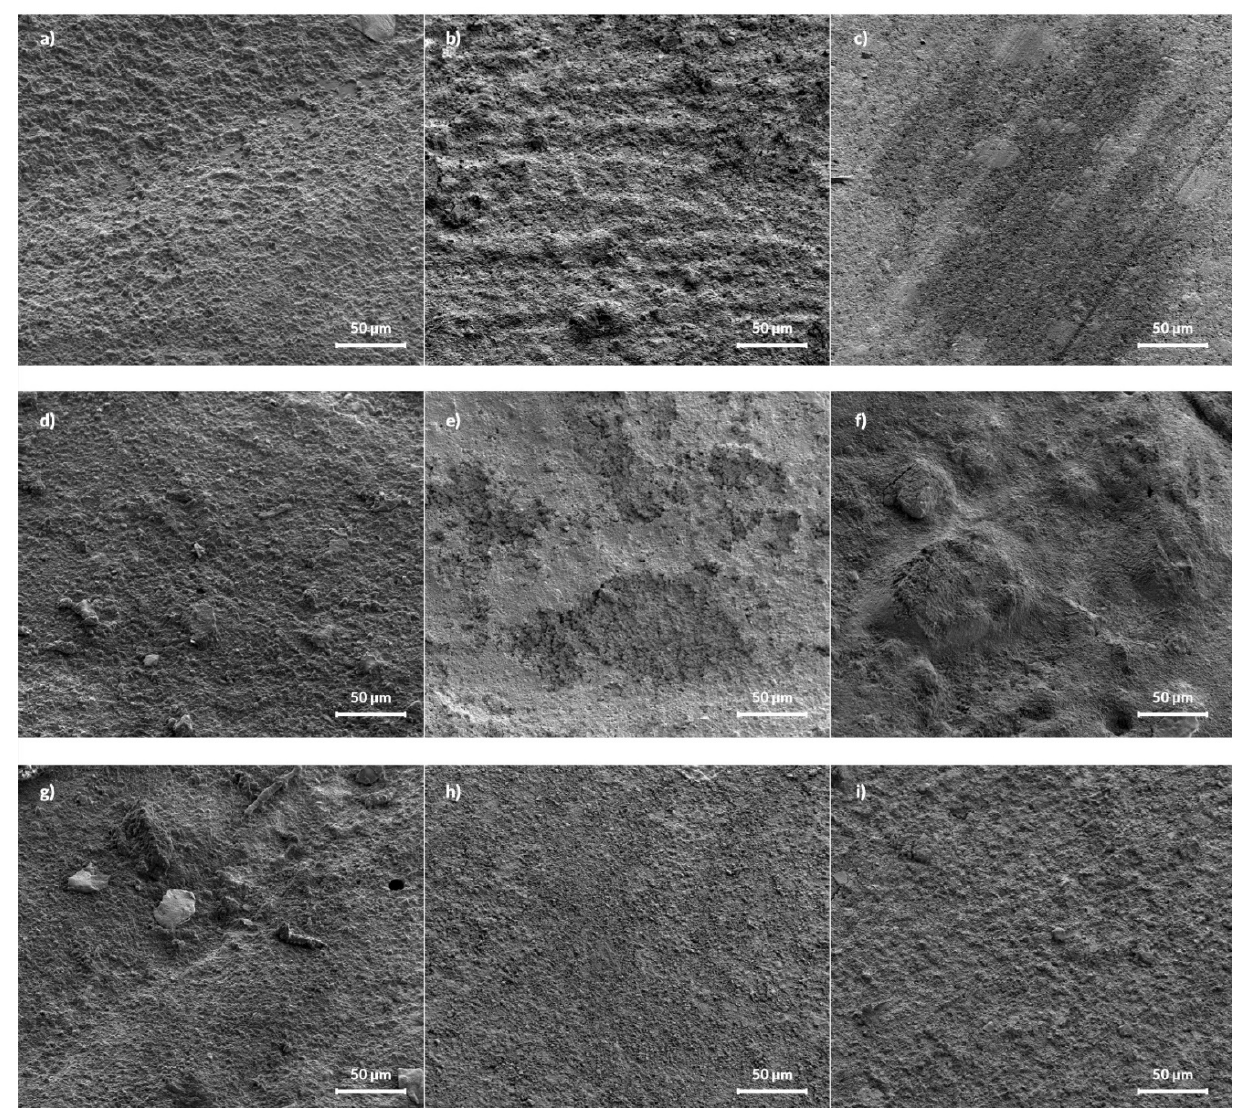
Figure 3. SEM images of pure i-FLOW ( a – c ), i-FLOW with 2%FAp ( d – f ), and 5%FAp ( g – i ) before release (left column) and after 12 weeks of release in deionized water (middle column) and 0.9% NaCl solution (right column), respectively.